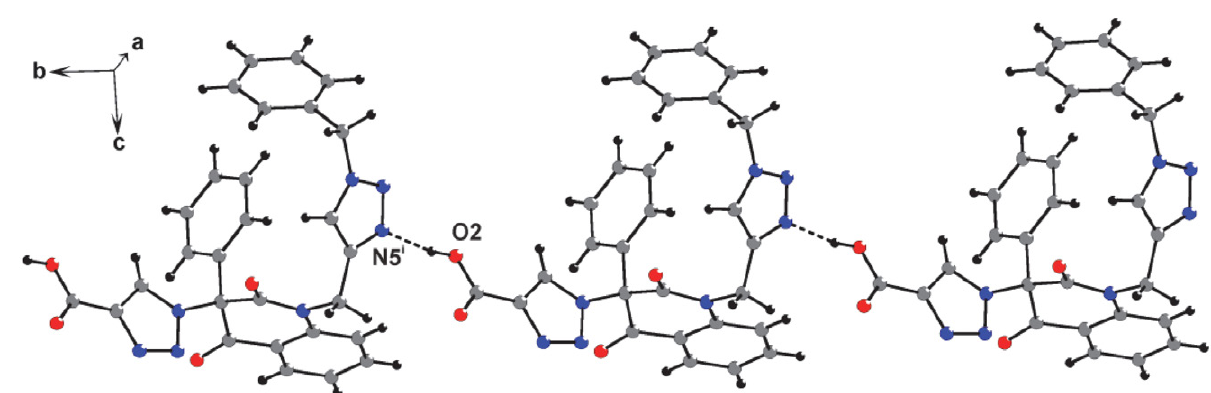
Figure 4. Hydrogen bonding interactions in the crystal structure of 12d ·2CDCl 3 showing the polymeric chain. Symmetry code: (i) x, y+1, z.